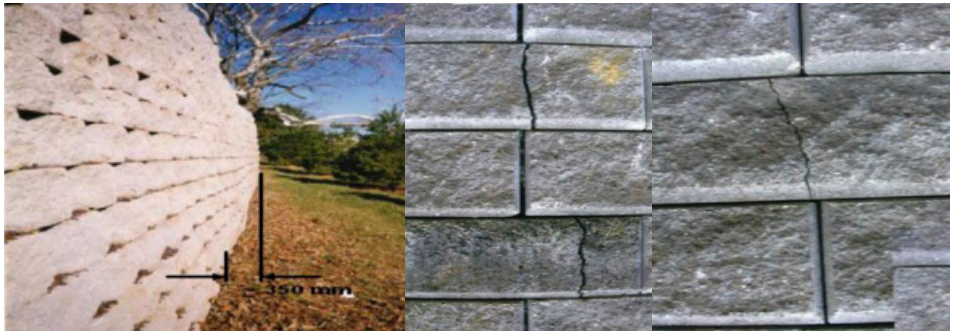
Figure 1. Excessive deformation of the retaining wall [6].